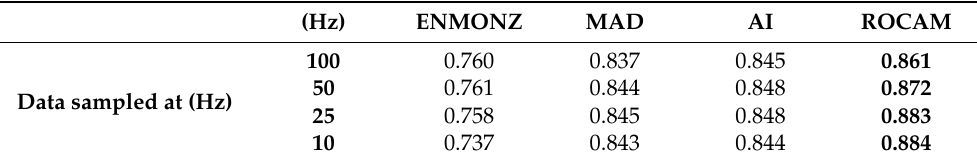
Table 1. Spearman correlation coefficients of the four acceleration summary measures with the five activity categories (sleep; sedentary, light, moderate, and vigorous PA) when processing three- dimensional acceleration data at different sample rates. (Hz)